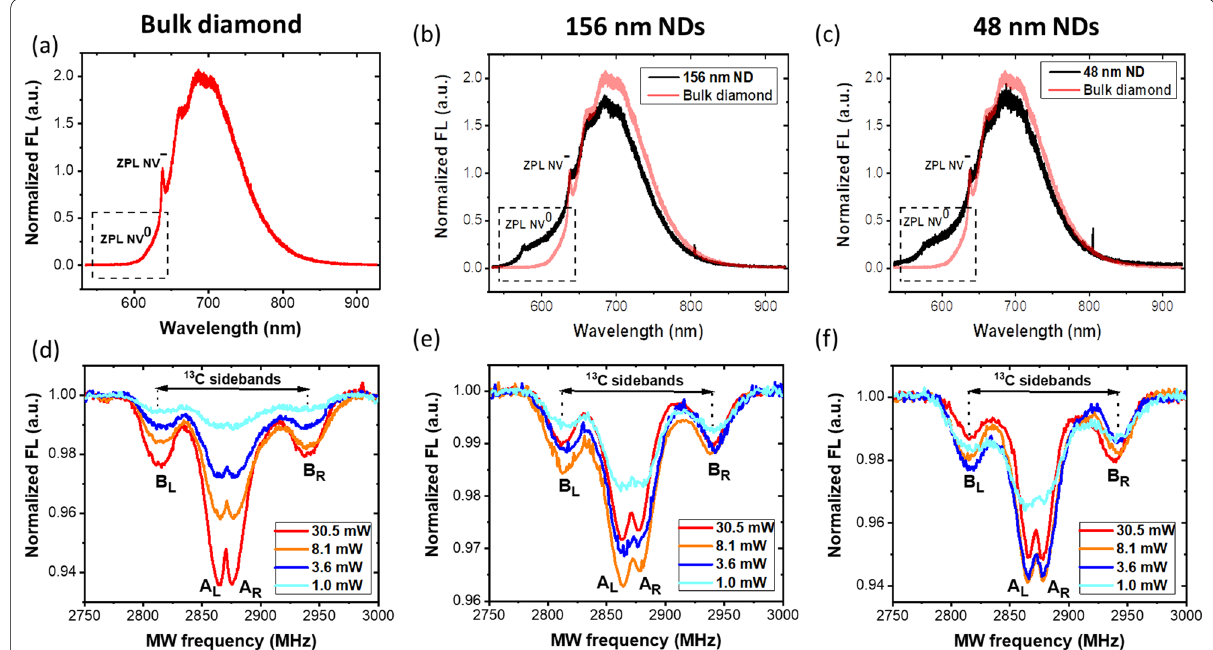
Fig. 2 Fluorescence and ODMR spectra. Fluorescence and ODMR spectra for the a , d bulk diamond, b , e 156 nm and c , f 59 nm NDs, respectively. a , b , c NV 0 and NV − fluorescence spectra are characterized by ZPL lines at 575 nm (NV 0 ) and 638 nm (NV − ). Due to surface effects, NDs have a larger NV 0 component than bulk diamond, where the NV 0 band is practically undetectable. Panels d , e , f show ODMR spectra at different laser power with fixed MW power. In the ODMR spectra, the NV − central lines ( A L and A R ) provide a measure of the spin polarization of | g,m s = 0 � ground state. The MW range was set to 2.75–3 GHz to show the NV − central lines and the 13 C‑coupled sidebands ( B L and B R ). In bulk diamond, ODMR contrast increases with increasing laser power. Conversely, in the NDs, the ODMR contrast increases up to 8.1 mW and then, decreases at higher laser powers. Both FL spectra and ODMR spectra were acquired under continuous laser irradiation. The small peak at ~ 800 nm in the FL spectra is an artifact of the Raman